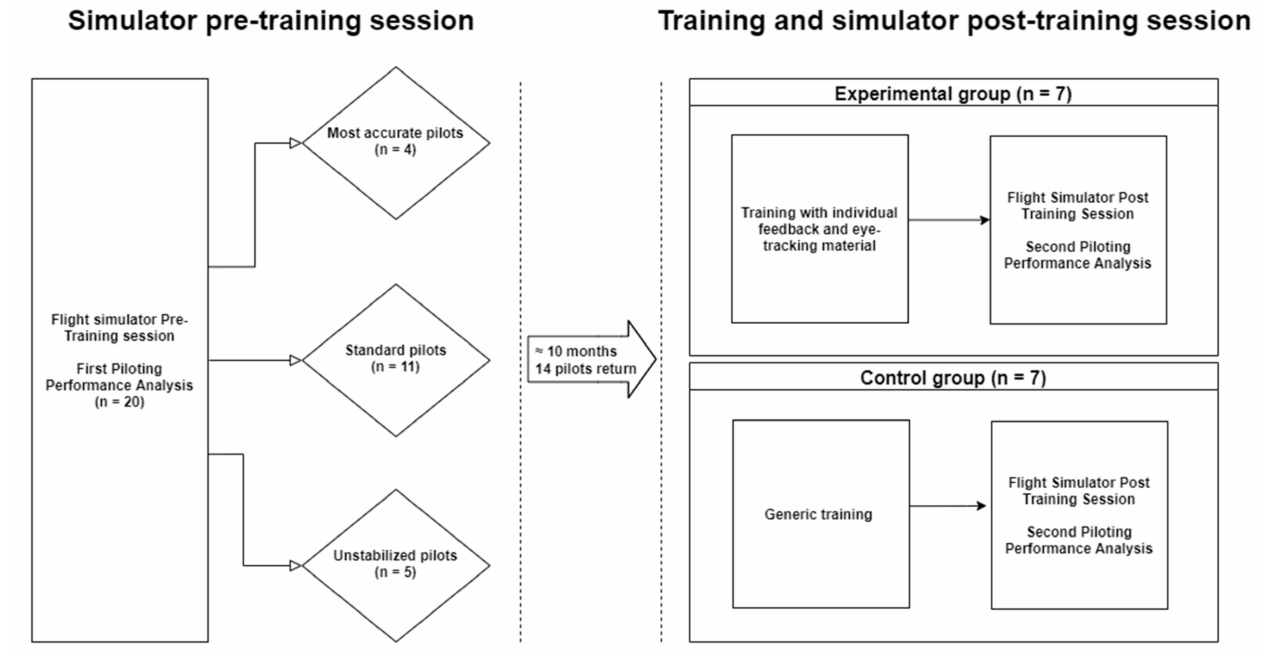
Figure 1. Experimental timeline of the two experimental